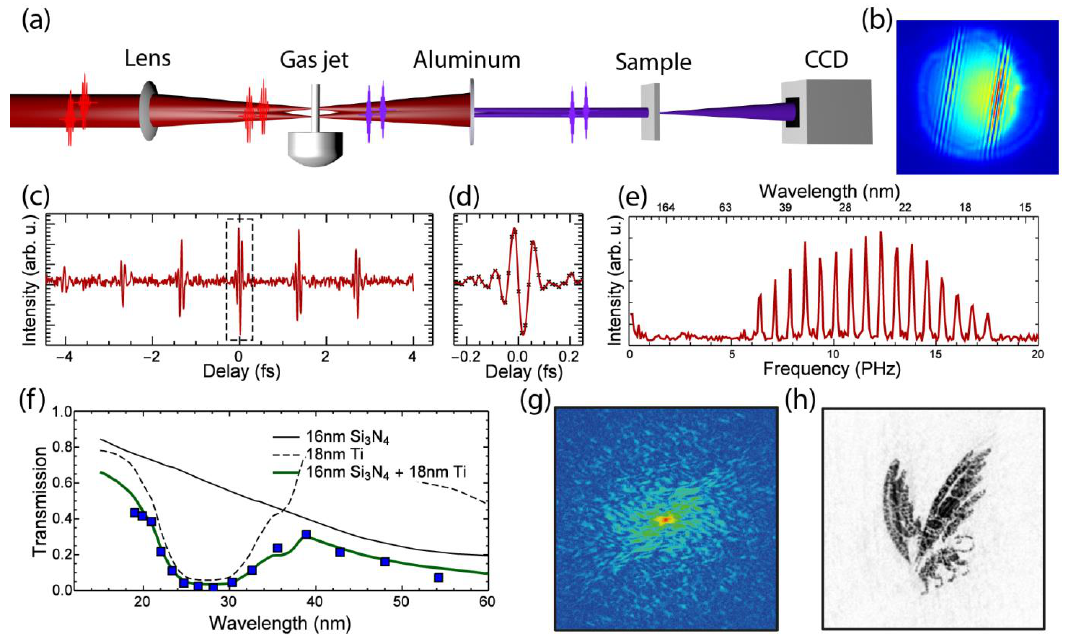
Fig. 1. Spatially-resolved Fourier-transform spectroscopy of high-harmonics. (a) Schematic overview of the high-harmonic generation setup. The output of the interferometer is focused in a gas jet to generate a pair of EUV pulses. A thin Aluminium filter is used to separate the EUV from the infrared, after which a transmissive sample can be positioned in the beam using a remotely controlled translation stage. An EUV-sensitive camera is used to detect the transmitted light. (b) Observed interference of the two EUV pulses in the absence of a sample. (c) Single pixel interference trace recorded while generating high-harmonics in neon and without a sample in the beam. (d) Zoom in of the centre portion of (c). (e) Spectrum of the high-harmonics generated in neon, averaged over ten neighbouring pixels. (f) Spatially resolved FTS measurement of the transmission of a thin Ti/Si3N4 film, compared to a reference spectrum transmitted through a hole in the same film. The spectral transmission matches with the expectations and correctly retrieves the thicknesses of the Titanium and Silicon Nitride. (g) Monochromatic diffraction pattern of a small isolated sample at 37 nm wavelength, measured using spatially resolved Fourier-transform spectroscopy with broadband high- harmonics. (h) Numerical reconstruction of the sample from the diffraction pattern in